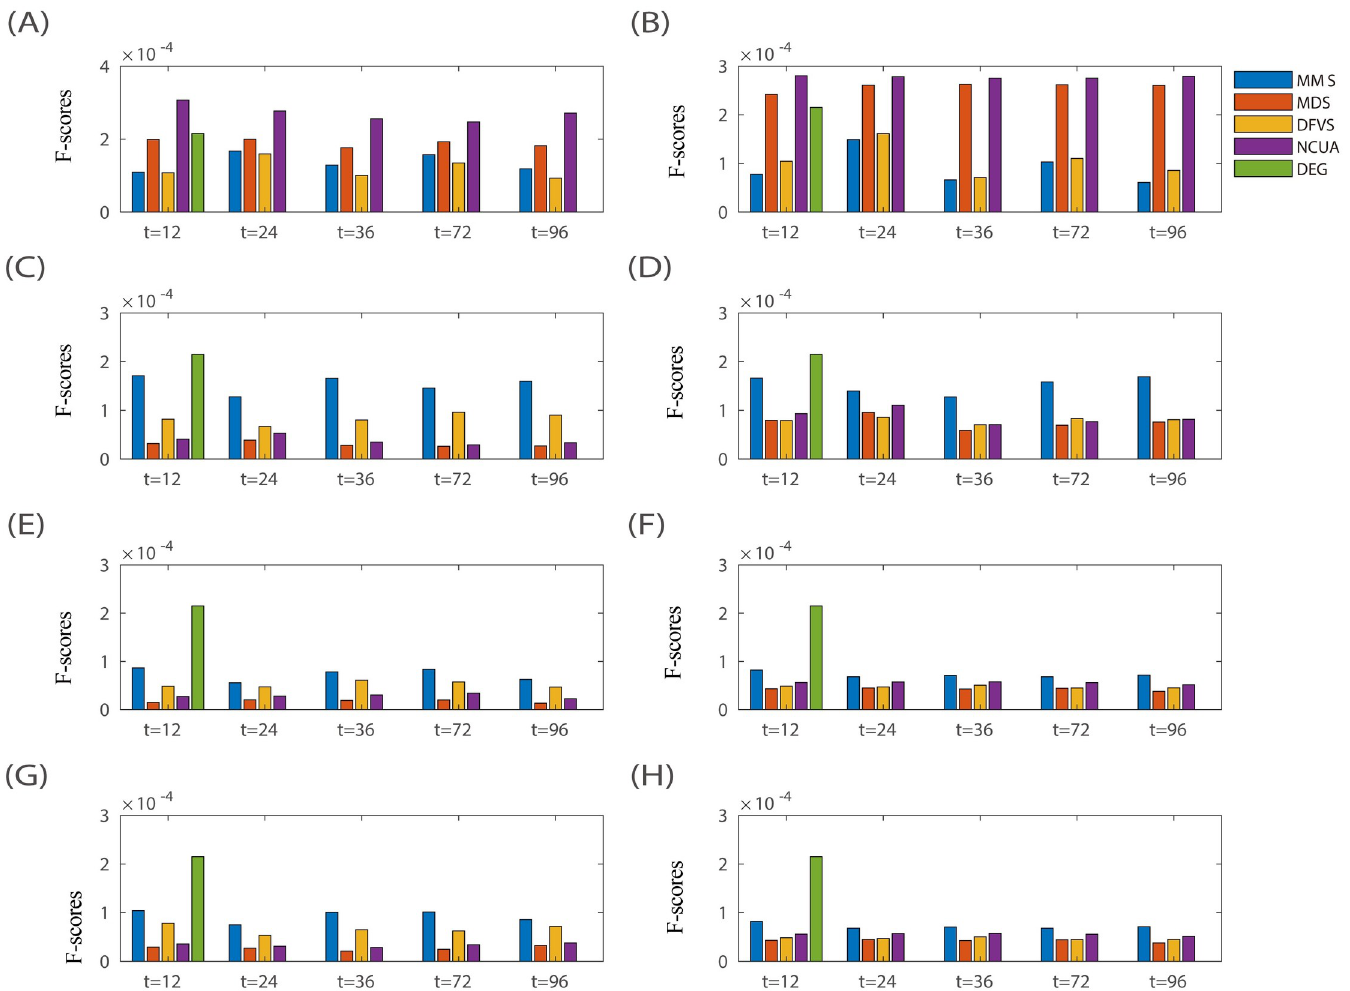
Fig 7. Identification of “dark genes”by different SSC workflows on Chu-time single cell dataset. The different state transition networks include (A) CSN_Net1, (B) CSN_Net2, (C) SSN_Net1, (D) SSN_Net2, (E) LIONESS_Net1, (F) LIONESS_Net2, (G) SPCC-Net1, and (H)